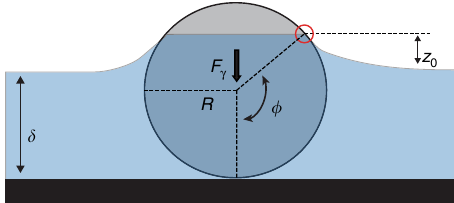
Fig. 5 Diagram of an agarose bead immersed in ASL. The diagram shows the force due to surface tension and the capillary forces acting on the bead, and the parameters relevant to Eq. (3). Where R is the radius of the agarose bead, γ is the surface tension of ASL, δ is the height of the ASL layer in the trachea, z 0 is the meniscus depth of the ASL due to the capillary effect of liquid around the agarose bead, θ is the contact angle between the ASL and the agarose. Our analysis shows that under our experimental conditions, the net effect of gravity and surface tension push the beads against the epithelium without causing signi fi cant The adhesion force due to surface tension and capillary forces on the bead (Fig. 5) can be calculated as 31, 32 :